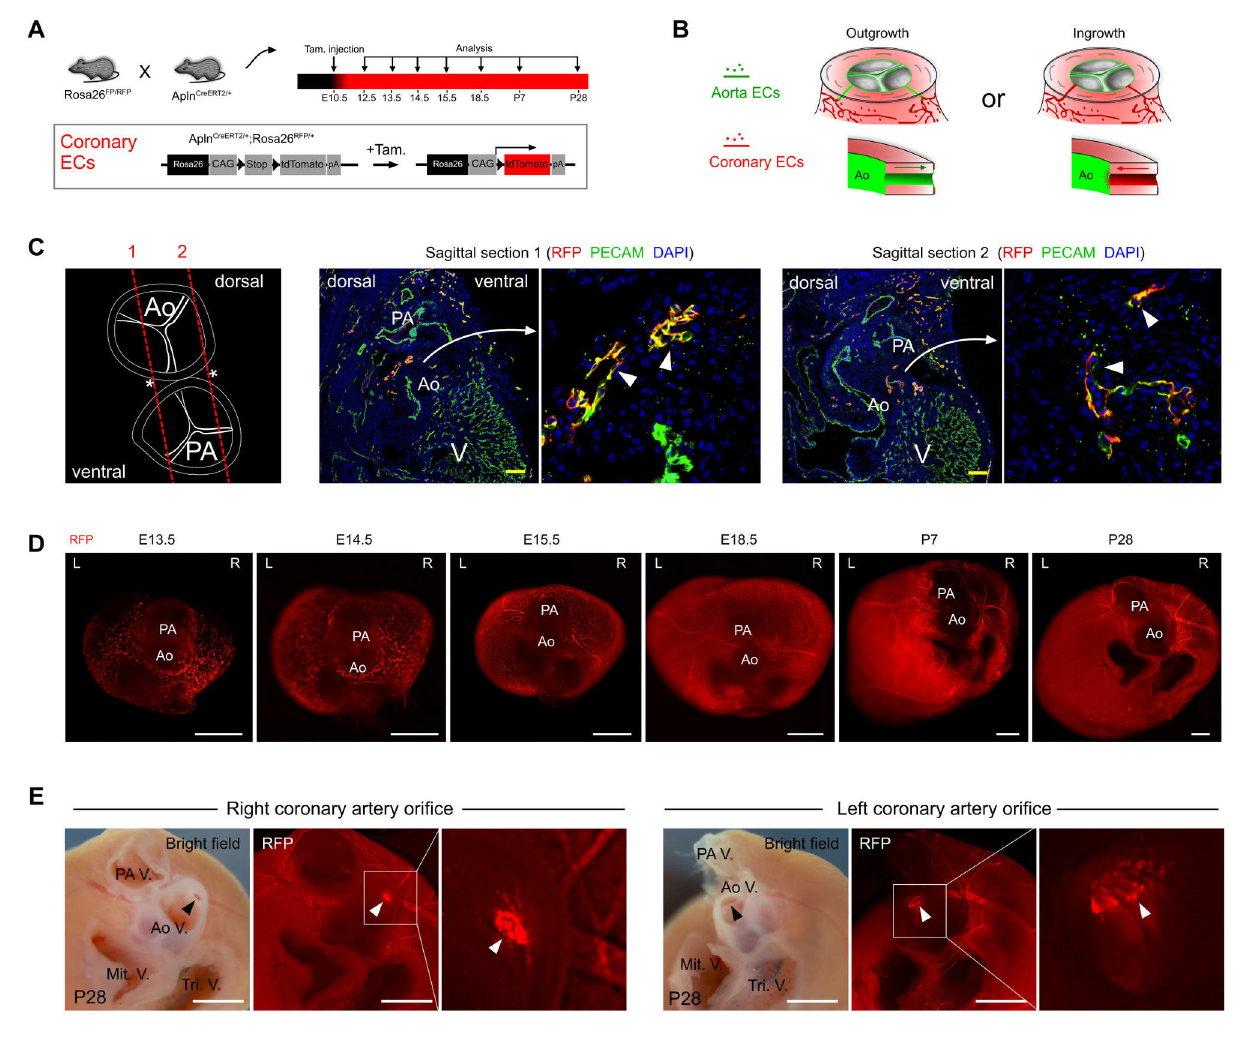
Figure 2. Lineage tracing of early coronary plexus endothelial cells (ECs) revealed their descendants in coronary artery stems and orifices. ( A ) Schematic showing tamoxifen pulse chase analysis of AplnCreERT2/+;Rosa26RFP/+ hearts used in panels C-E. Tamoxifen was administered at E10.5 and analysis was performed between E13.5 to postnatal day P28. ( B ) Schematic showing ingrowth and outgrowth model. ( C ) Apln+ coronary ECs contributed to left and right peri-truncal capillaries (RFP) at E12.5. Section 1 and 2 are sagittal sections of embryos. ( D ) Whole mount fluorescence view from top of E13.5 to P28 AplnCreERT2/+;Rosa26RFP/+ hearts. ( E ) Visualization of left and right coronary artery orifice from inside the aorta. Note RFP+ patch (arrowhead) at the coronary artery orifices, and its extension into the coronary artery stems. Ao, aorta; CA, coronary artery; CV, coronary vein; PA, pulmonary artery; PA V., PA valve; Ao V., Ao valvle; Mit. V., mitral valve; Tri. V., tricuspid valve. Yellow bar = 100 um; white bar = 0.5 mm.